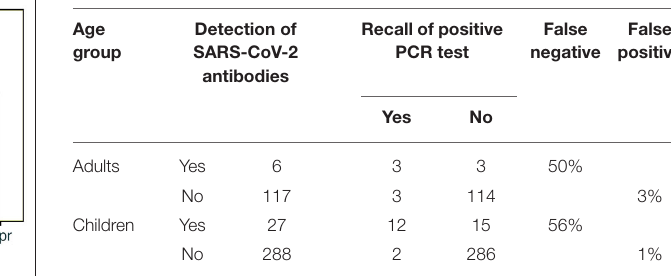
TABLE 3 | Recall of SARS-CoV-2 infection and measured antibodies against